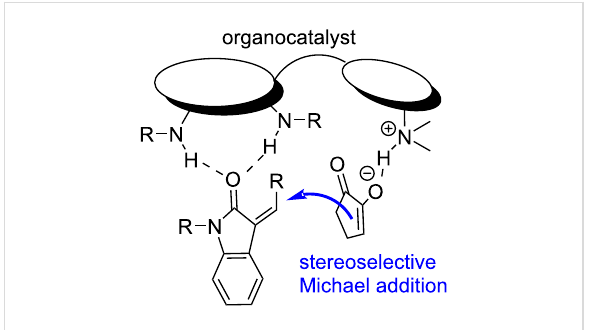
Figure 1: Model of the catalyst